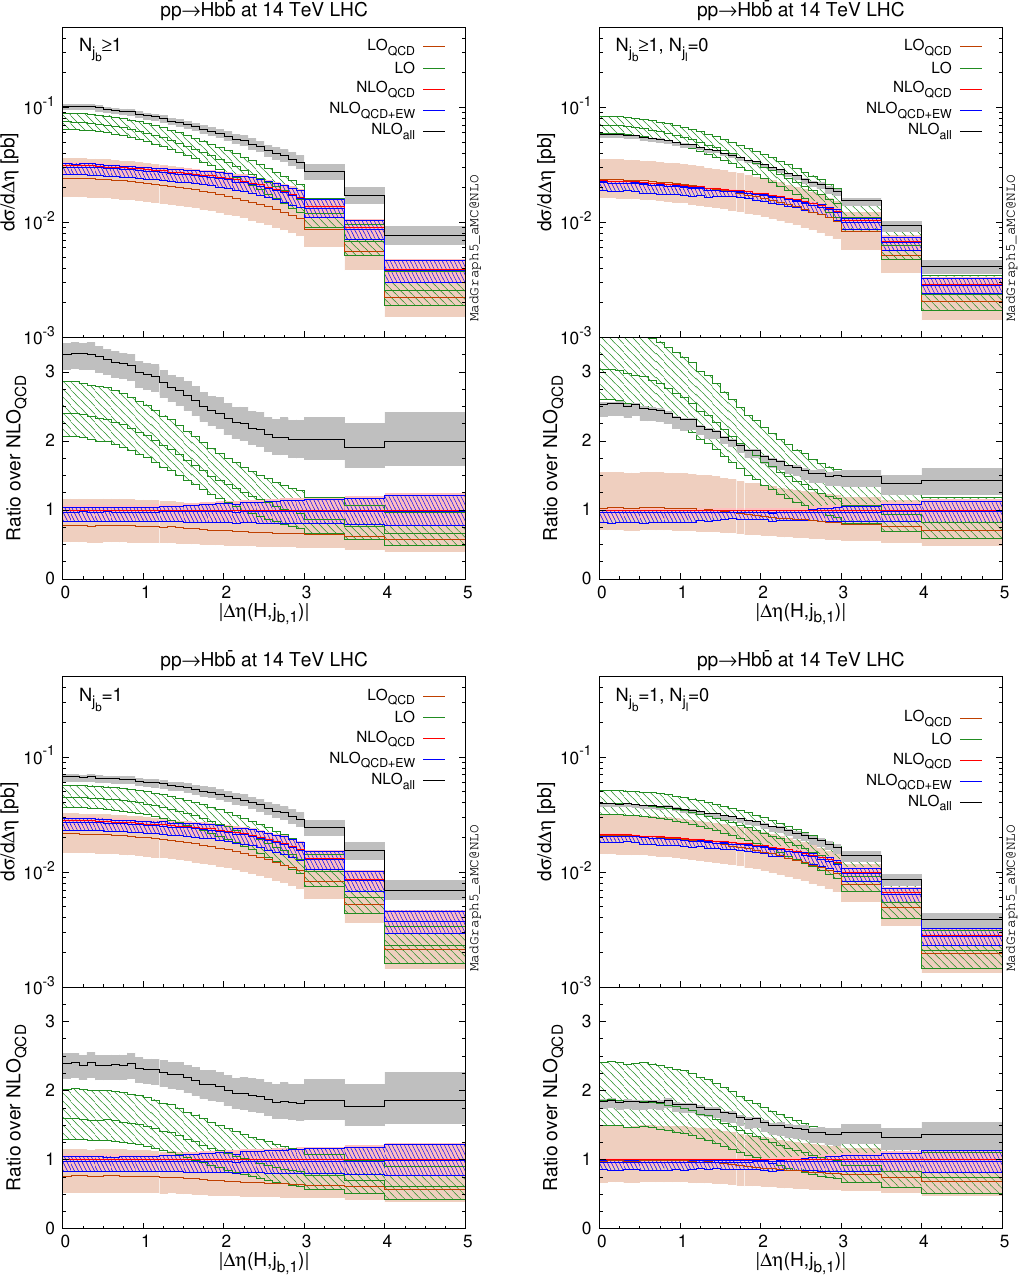
Figure 7 . The | ∆ η ( H, j b, 1 ) | distribution for N j the light-jet veto is